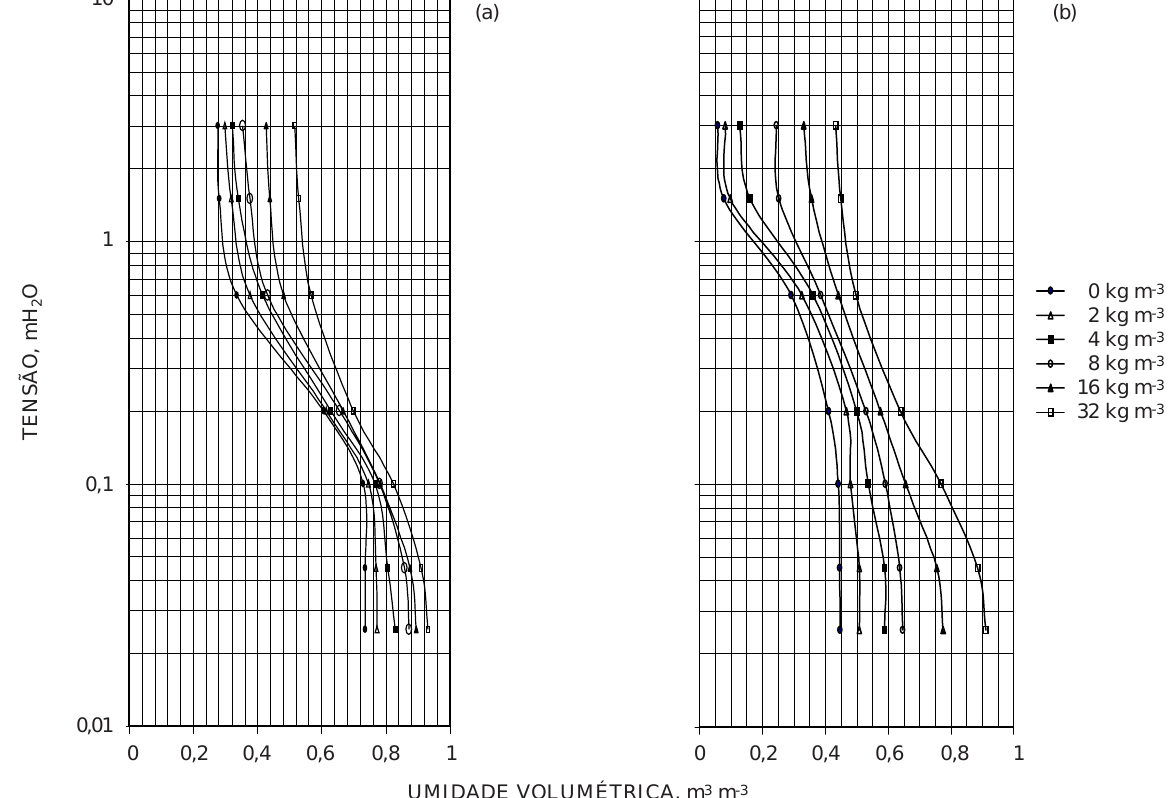
Figura 1. Curva de retenção de água para o Latossolo (a) e Areia Quartzosa Marinha (b), para diversas concentrações de